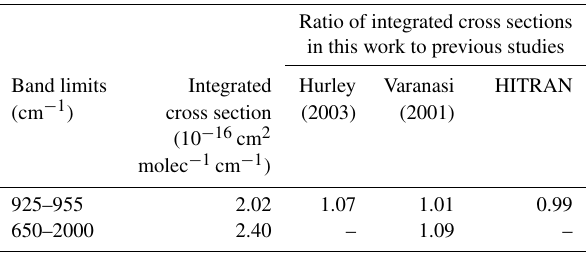
Table 4. Integrated absorption cross sections for SF 6 measured in this work and ratios with values obtained by GEISA (Ges- tion et Etude des Informations Spectroscopiques Atmosphériques; Jacquinet-Husson et al., 2011; Hurley, 2003; Varanasi, 2001) and HITRAN (HIgh-resolution TRANsmission molecular absorption database; Rothman et al.,